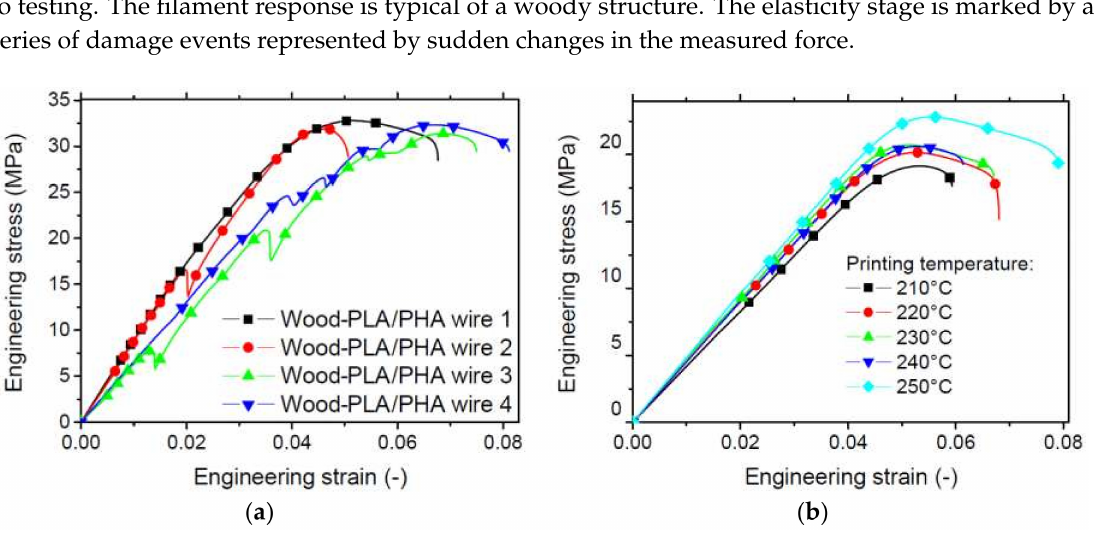
Figure 5. Comparison between the tensile response of ( a ) as-received wood-PLA / PHA filament and ( b ) 3D-printed specimens of the same